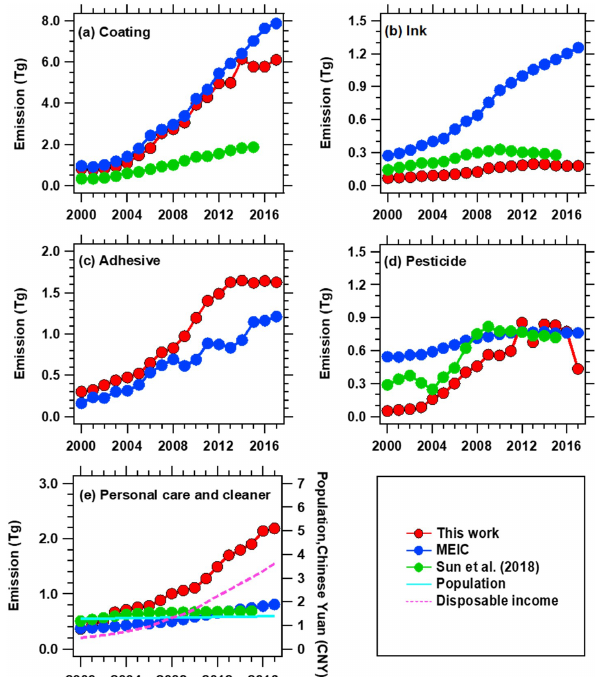
Figure 7. Comparisons of emission estimates for (a) coatings, (b) inks, (c) pesticides, (d) adhesives, and (e) personal care products and cleaners (industrial detergents are not included in this figure) between this work and other studies (Li et al., 2019; Sun et al., 2018). Also shown are population (billion) and disposable income of households (10 13